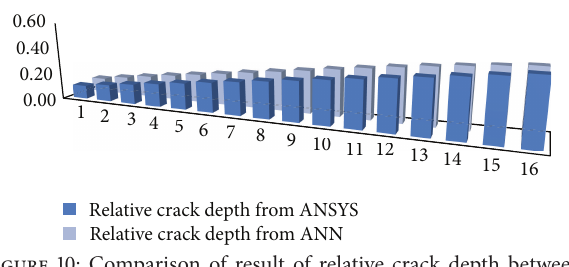
Figure 10: Comparison of result of relative crack depth between